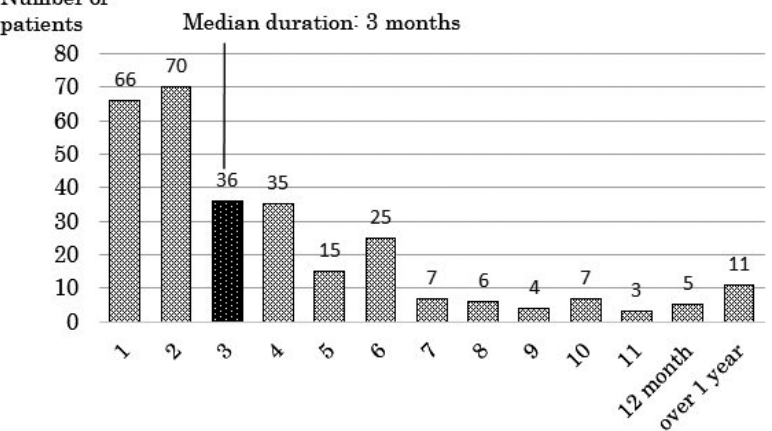
Figure 6. Duration of zinc replacement therapy needed for patients with zinc deficiency to feel sub- jective improvement in symptoms.